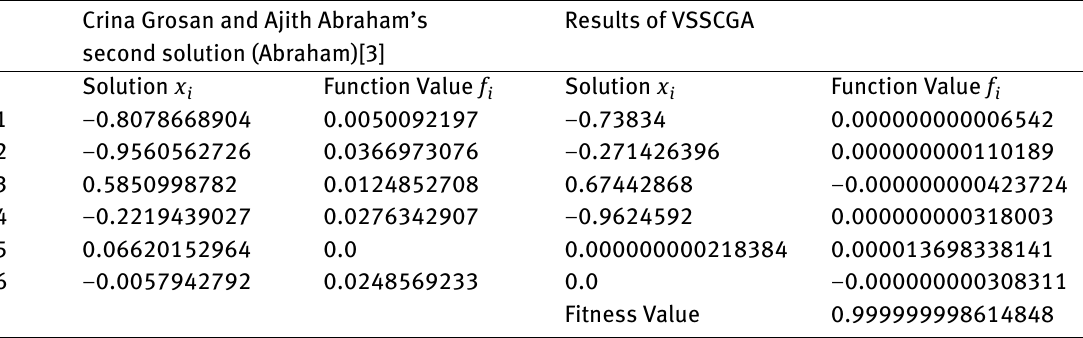
Table 38: Comparison of VSSCGA’s results with Crina Grosan and Ajith Abraham’s results for Neurophysiology Application problem (case